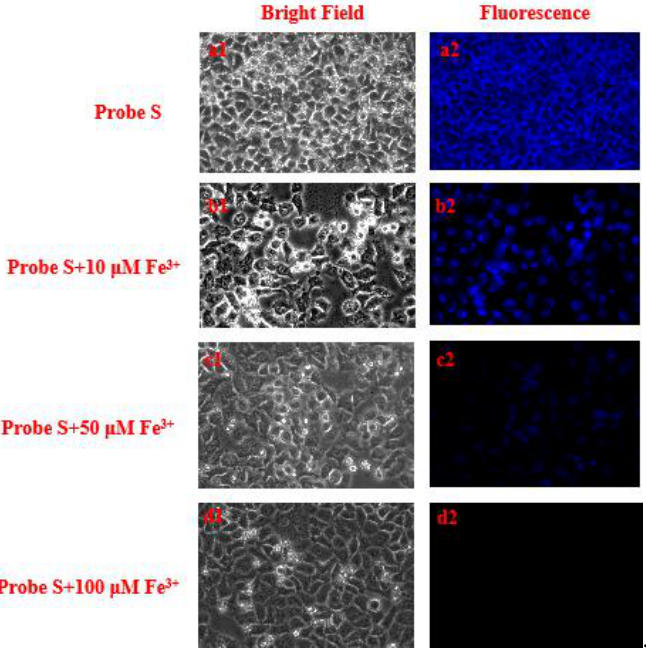
Figure 10. Bright-field and fluorescence images of HeLa cells incubated with probe S (10.0 μM) ( a1 , a2 ) and further incubated with addition of Fe 3+ (0, 10.0, 50.0, 100.0 μM) ( b2 , c2 , d2 ); their corresponding bright field images ( b1 , c1 , d1 ) at 400–480 nm (the scale bar is 20 µm).